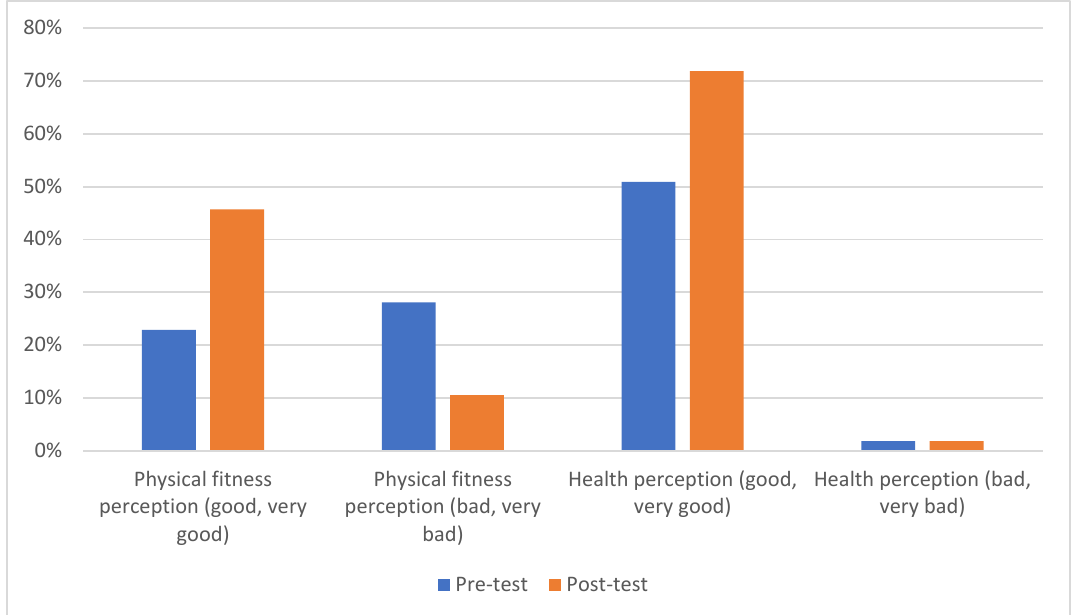
Figure 1. Percentage of responses for perception of physical fitness and health.